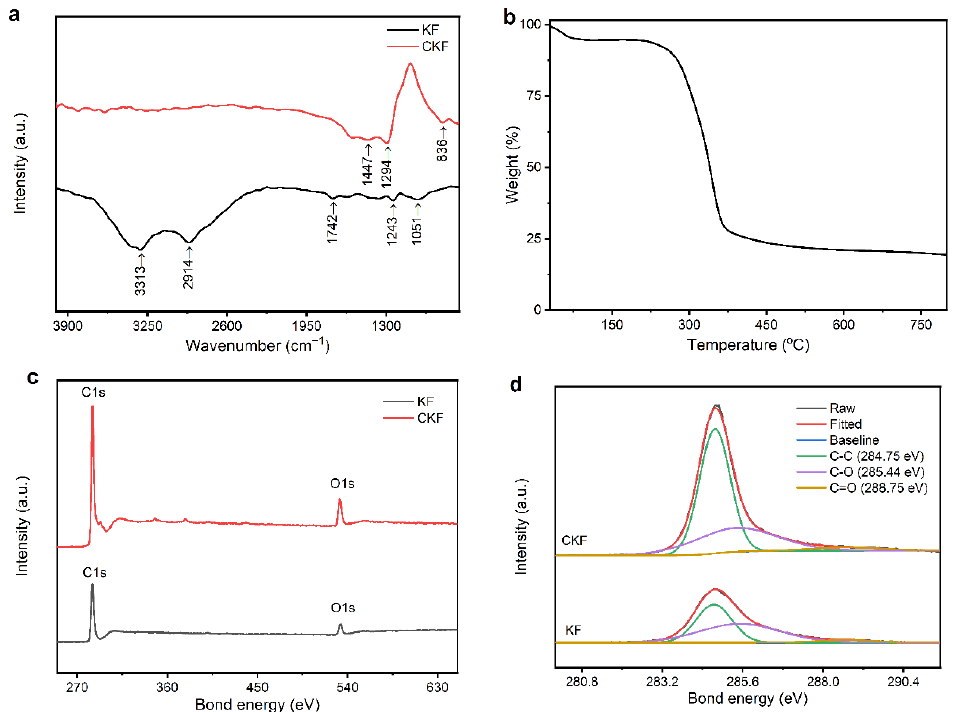
Figure 2. ( a ) FTIR of the KF and CKF; ( b ) TGA of the KF; ( c ) XPS survey spectra and ( d ) C1s spectra of the KF and CKF.